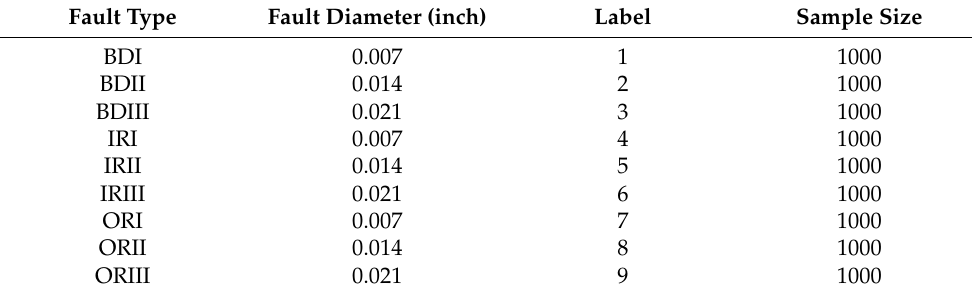
Table 1. Data information for the nine types of fault states.